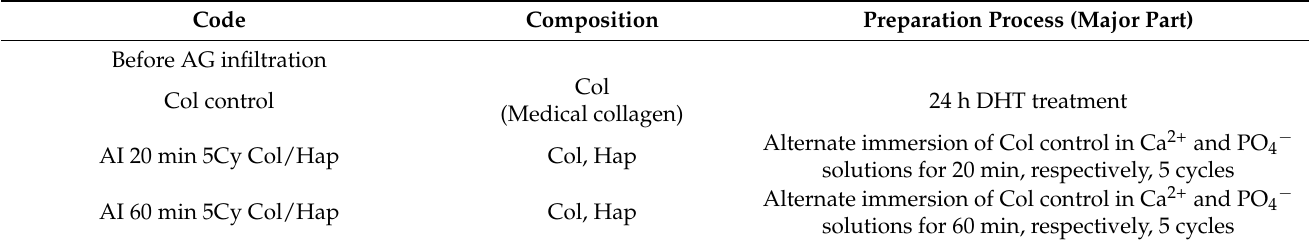
Table 1. Code, composition, and preparation process (major part) of samples examined.